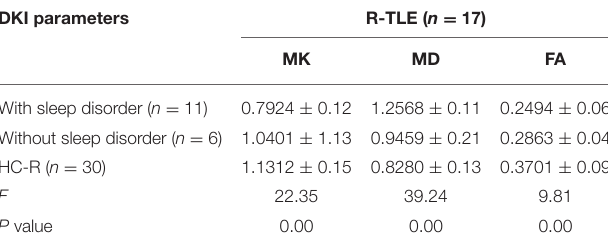
TABLE 4 | ANOVA of DKI parameters between R-TLE with or without sleep disorders and the healthy controls. DKI parameters R-TLE ( n = 17) MK MD